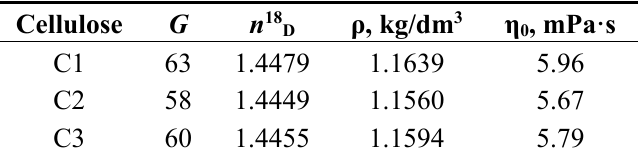
Table 2. Yield of condensate [ G (%) of cellulose dry mass] and physicochemical characteristics of condensates ( Z = 104 cm 2 /g)